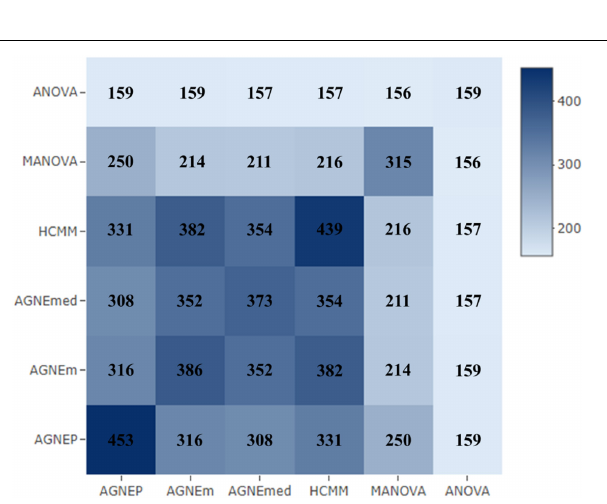
FIGURE 7 | The heat map of confirmed genes for the six methods in analysis of the Arabidopsis real dataset. The darker the square, the greater the number of confirmed genes detected two